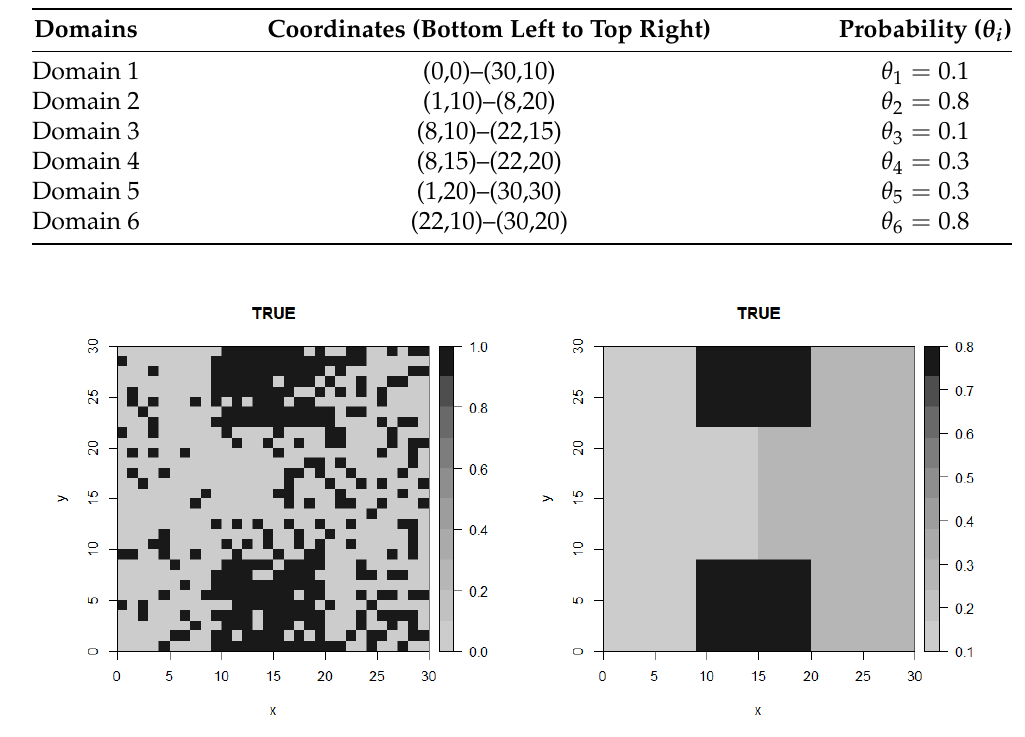
Figure 2. Domains as determined by the true profile (Example